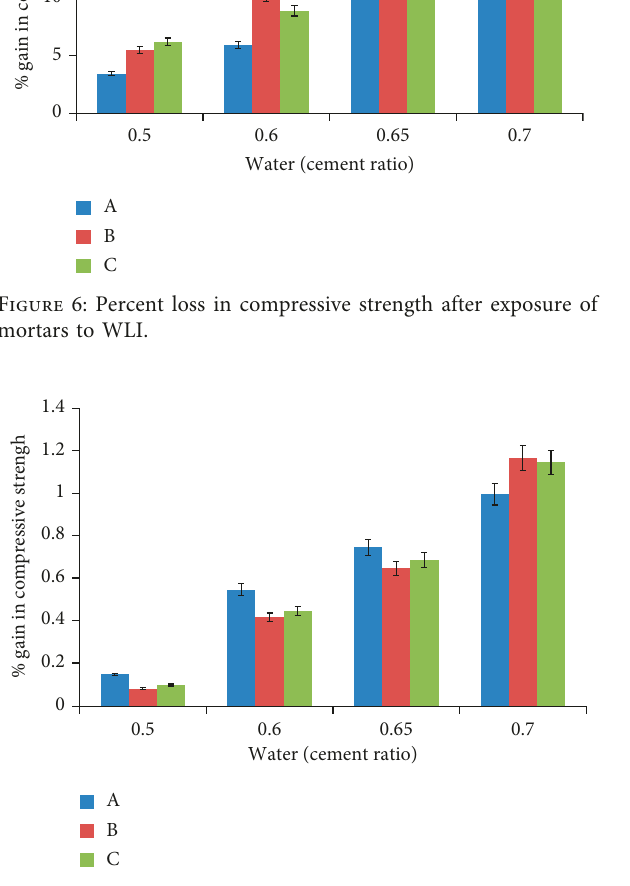
Figure 7: Percent gain in compressive strength after exposure of mortars to